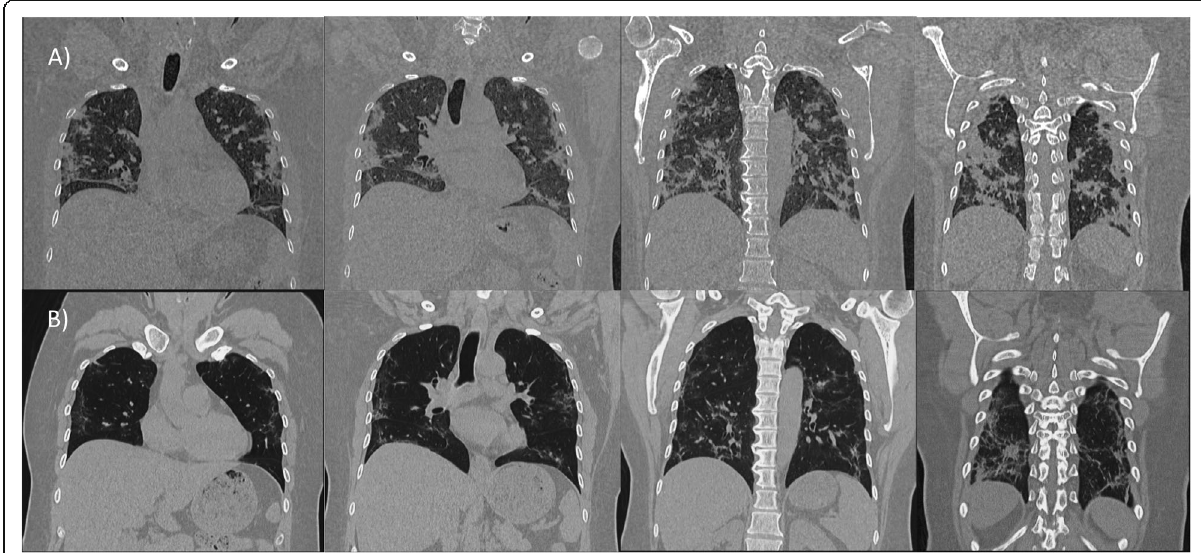
Fig. 5 Case 51: 44-year-old female (healthcare worker), with a history of hypertension and hypothyroidism under treatment, score 4. CT chest: a day of admission (April 14th). Multi-focal areas of ground-glass opacification/consolidation in the bilateral lungs-lesions. b Day 5 after treatment (April 20th). The ground-glass opacities and organized consolidation is seen previously in both lungs in subpleural and peripheral locations appear to be less dense with less size comparing with the previous study done on 14 April 2020 suggestive of good responding to